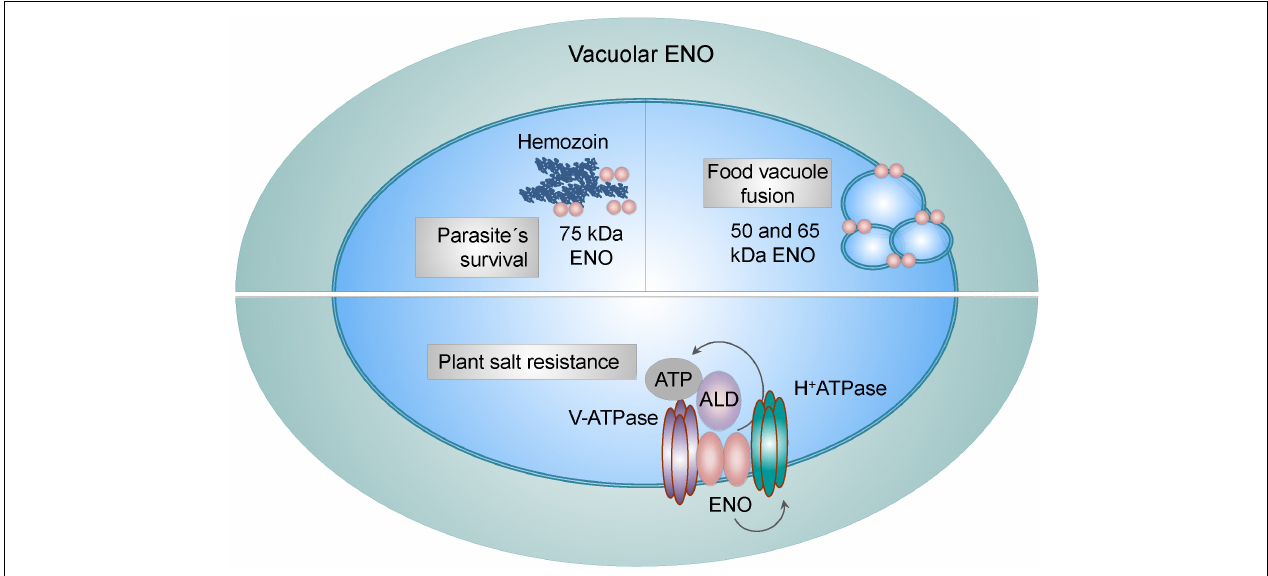
FIGURE 3 | Vacuole-related functions of ENO. Vacuole-associated ENO in parasites exists in three different variants: the low (50 and 65 kDa) and high (75 kDa) molecular weight forms. While the low molecular weight ENO variants regulate fusion of food vacuoles, the 75 kDa form interacts with hemozoin, a disposal product of hemoglobin digestion. Binding of ENO to hemozoin plays a role in parasites survival. In plants, ENO binds to subunits of the vacuolar H + -ATPase and V-ATPase and stimulates V-ATPase activity in an aldolase (ALD)-dependent manner by increasing the affinity for ATP. This mechanism is used by plants to overcome high salt